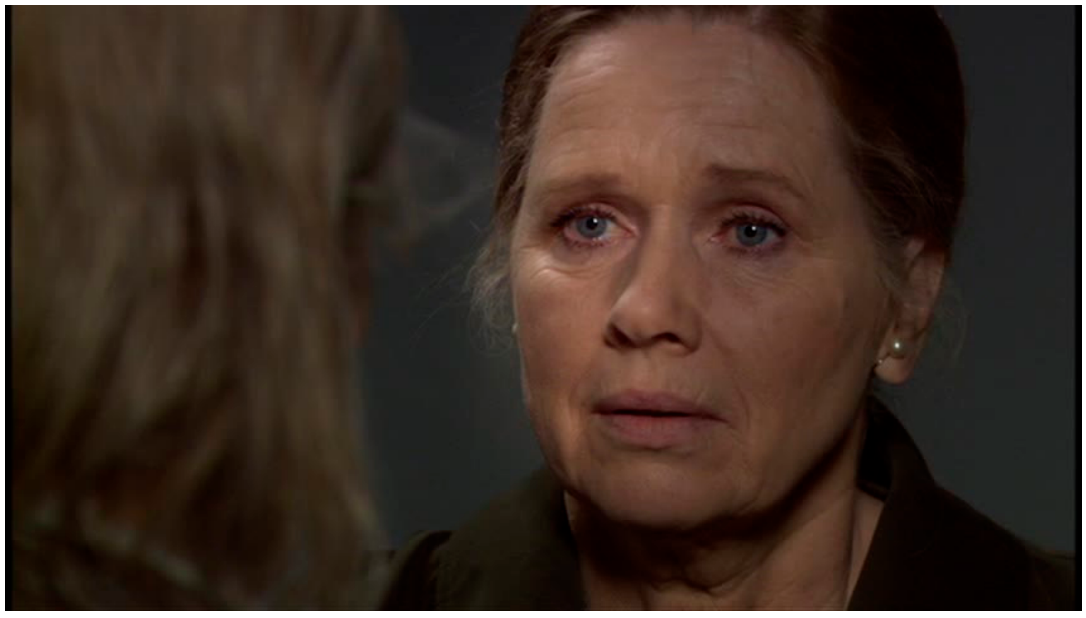
Figure 25. Silence, Touch, Communion.